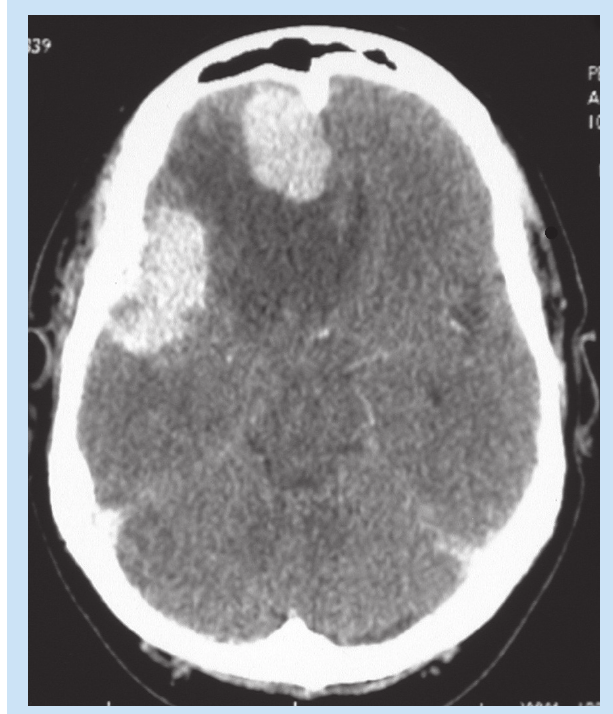
Fig. 1b. Post-contrast image showing contrast enhanced right temporal and frontal parasagittal